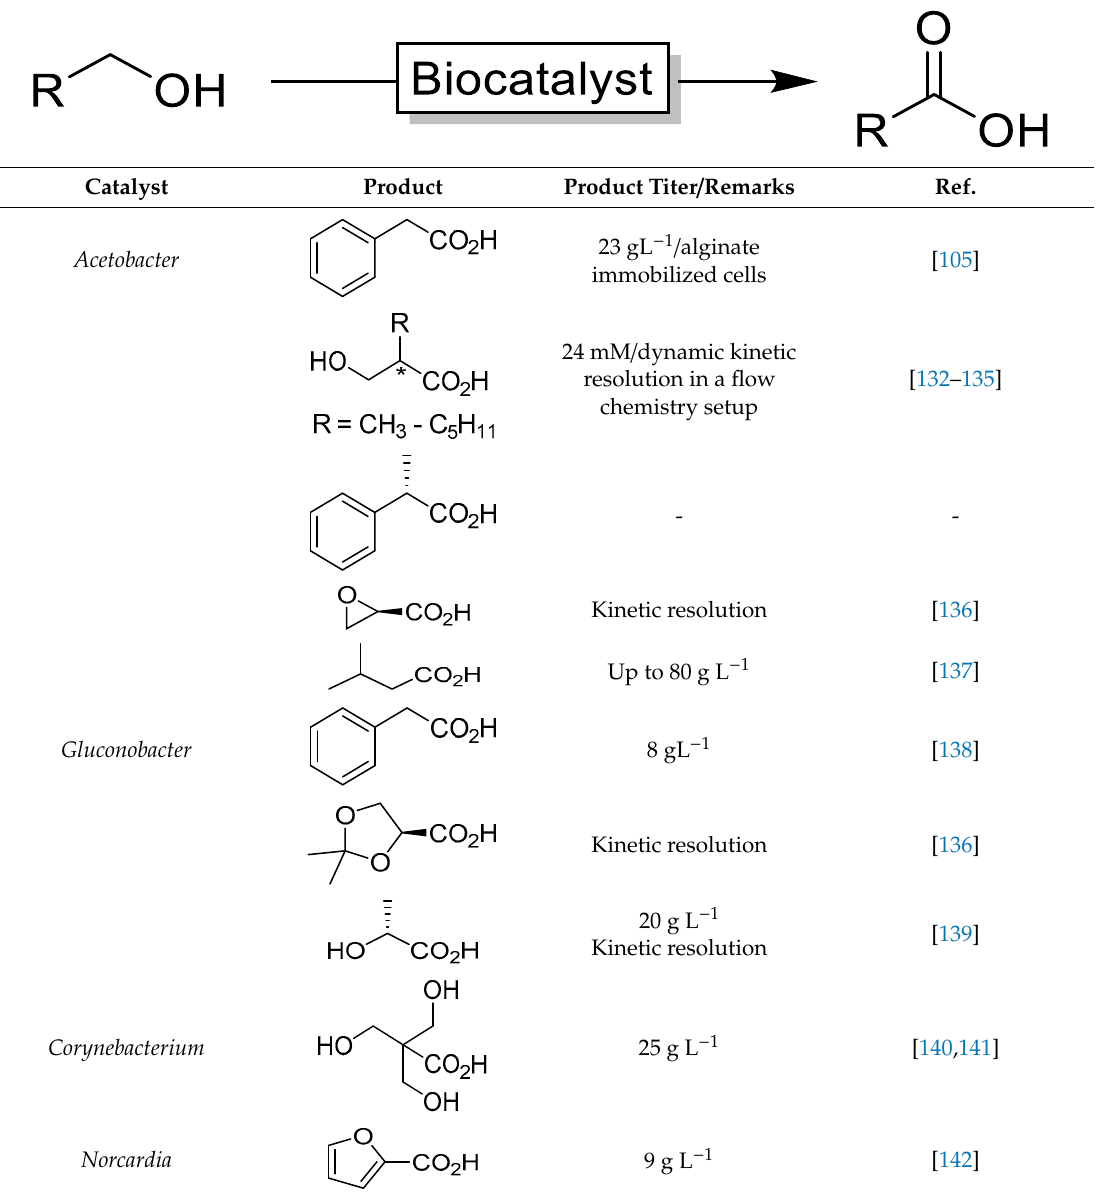
Table 3. Selection of microbial through oxidations of primary alcohols. Table 3 . Selection of microbial through oxidations of primary alcohols. Table 3 . Selection of microbial through oxidations of primary alcohols.